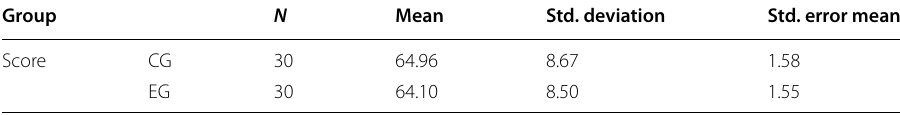
Levene’s t -test for equality of test for equality of variances